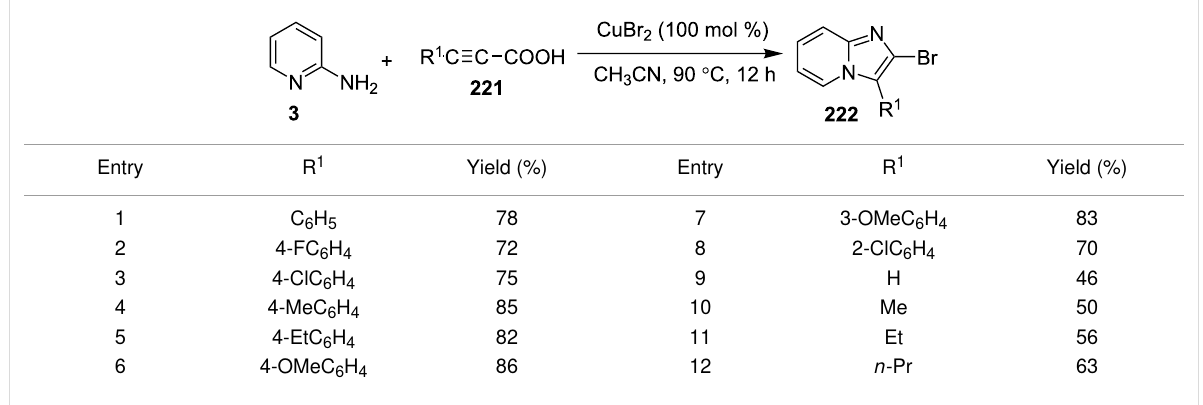
Table 6: Cu(II)-promoted one-pot reaction for synthesizing